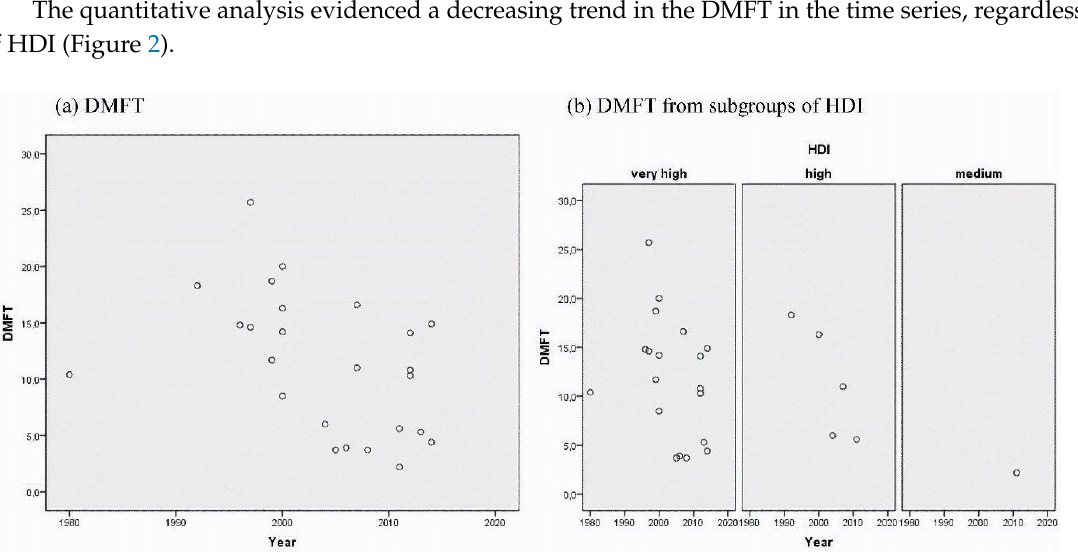
Figure 2. Change of the DMFT (decayed, missing, filled teeth) mean over time. Graphs comparing caries in adults ( a ) total of 25 studies included in the quantitative analysis of caries experience, ( b ) from countries with very high, high, and medium HDI (Human Development Index).